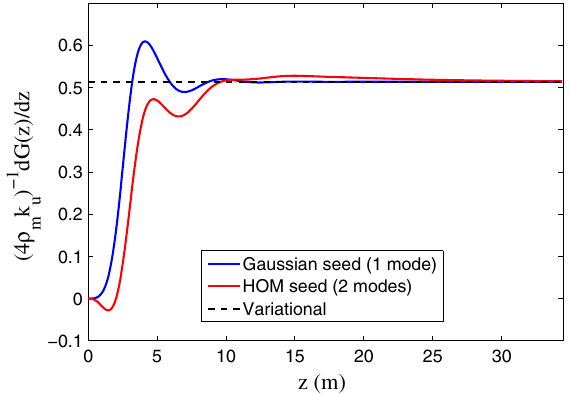
FIG. 8. Local power growth rate ð 1 =P Þ dP=dz (in units of k ) for a Gaussian (blue) and a GL 4 (cid:13) m u The dashed line is the growth rate of the fundamental FEL mode, obtained from the variational method.